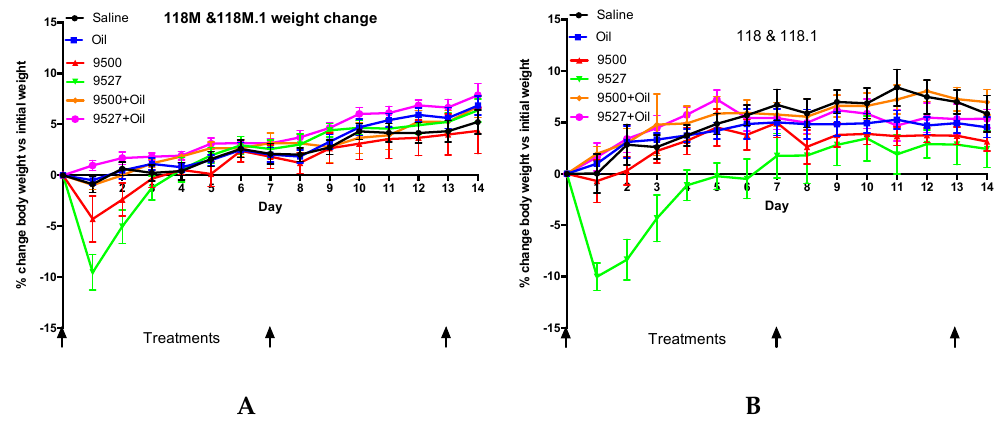
Figure 1. Two-week weight changes of mice relative to treatments. ( A ) is for male and ( B ) is for female mice, with n = 6 for each sex and treatment. Error bars shown are standard error.